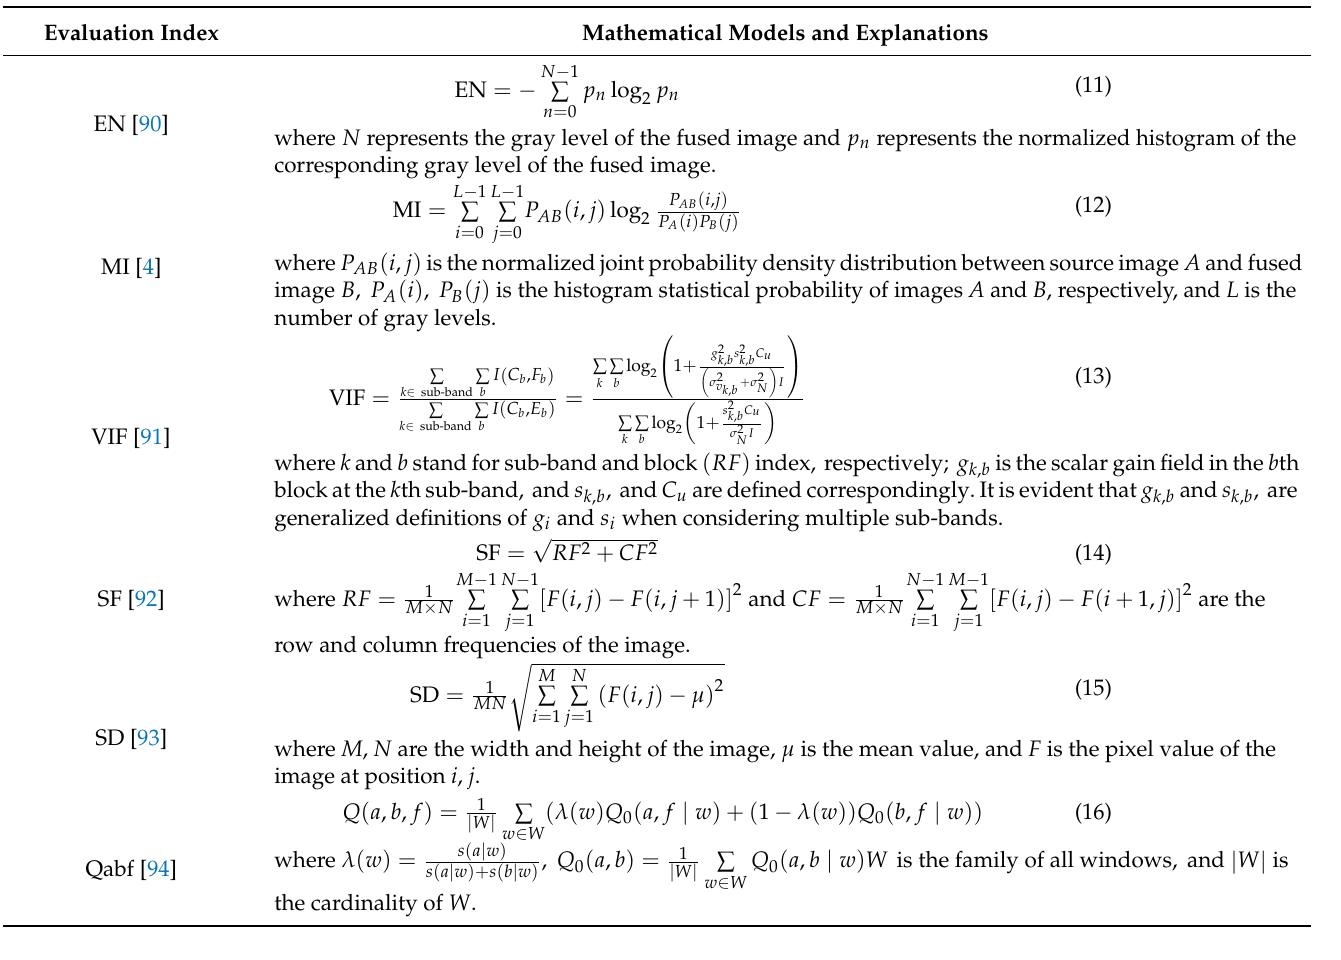
Table 2. Typical evaluation indices and mathematical